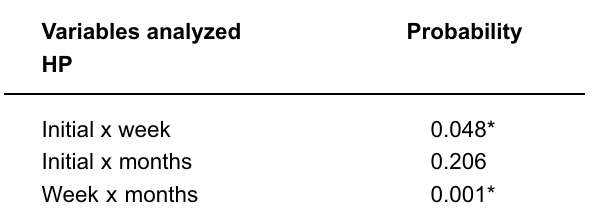
TABLE 1- Probability found, when applying the Wilcoxon’s rank sum test of the values of head position obtained at the beginning of the study and after 1 week and 1 month of occlusal splint use